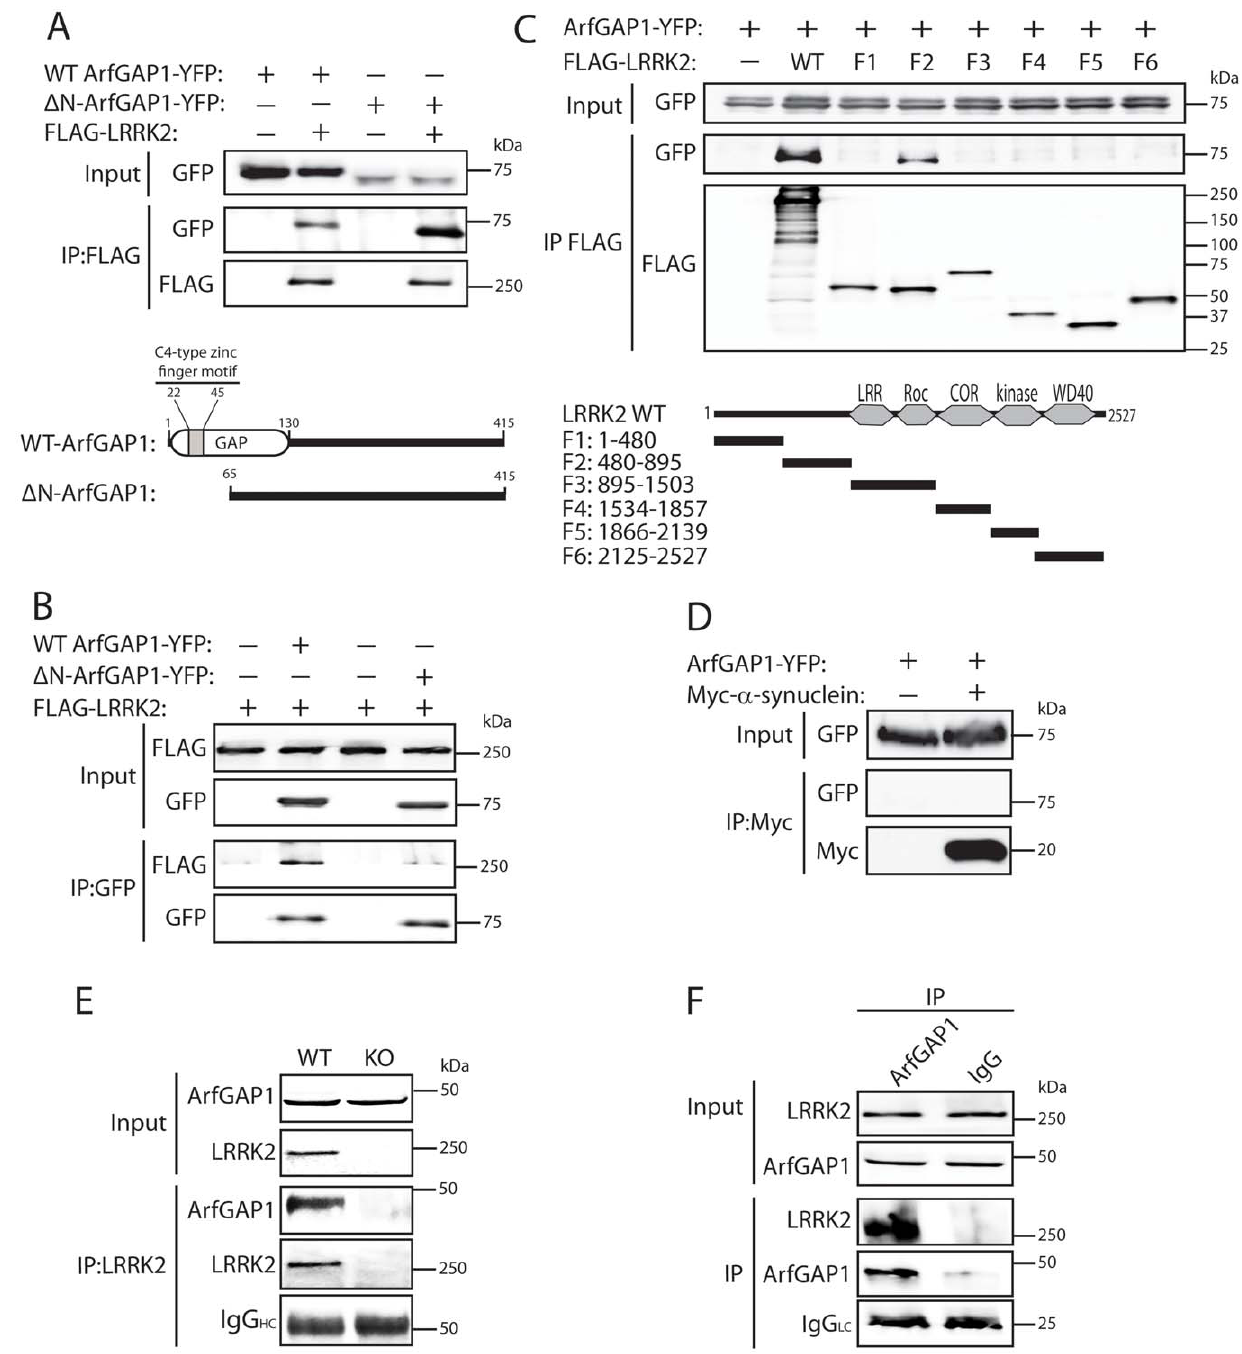
Figure 1. LRRK2 interacts with ArfGAP1 in mammalian cells and invivo . (A) YFP-tagged ArfGAP1 (WT or D N) interacts with full-length FLAG- tagged LRRK2 following immunoprecipitation (IP) with anti-FLAG antibody from HEK-293T cells. Domain organization of ArfGAP1 constructs is indicated. (B) Interaction of ArfGAP1-YFP (WT or D N) and FLAG-LRRK2 following reverse IP with anti-GFP antibody from HEK-293T cells. (C) Domain mapping reveals the interaction of ArfGAP1-YFP with full-length (WT) LRRK2 and residues 480–895 of LRRK2 (fragment F2) following IP with anti-FLAG antibody from HEK-293T cells. Domain organization of LRRK2 deletion mutants is indicated. (D) Myc- a -synuclein fails to interact with ArfGAP1-YFP following IP with anti-myc antibody from HEK-293T cells. (E) LRRK2 interacts with ArfGAP1 in cerebral cortex extracts from WT mice but not LRRK2 knockout (KO) mice following IP with anti-LRRK2 antibody (clone c41-2). (F) ArfGAP1 interacts with LRRK2 in mouse cerebral cortex following IP with anti-ArfGAP1 antibody but not with a rabbit IgG control. IgG light chain (LC) indicates the equivalent amounts of IgG used for IP. Molecular mass markers are indicated in kilodalton (kDa). Data are representative of at least two independent experiments.